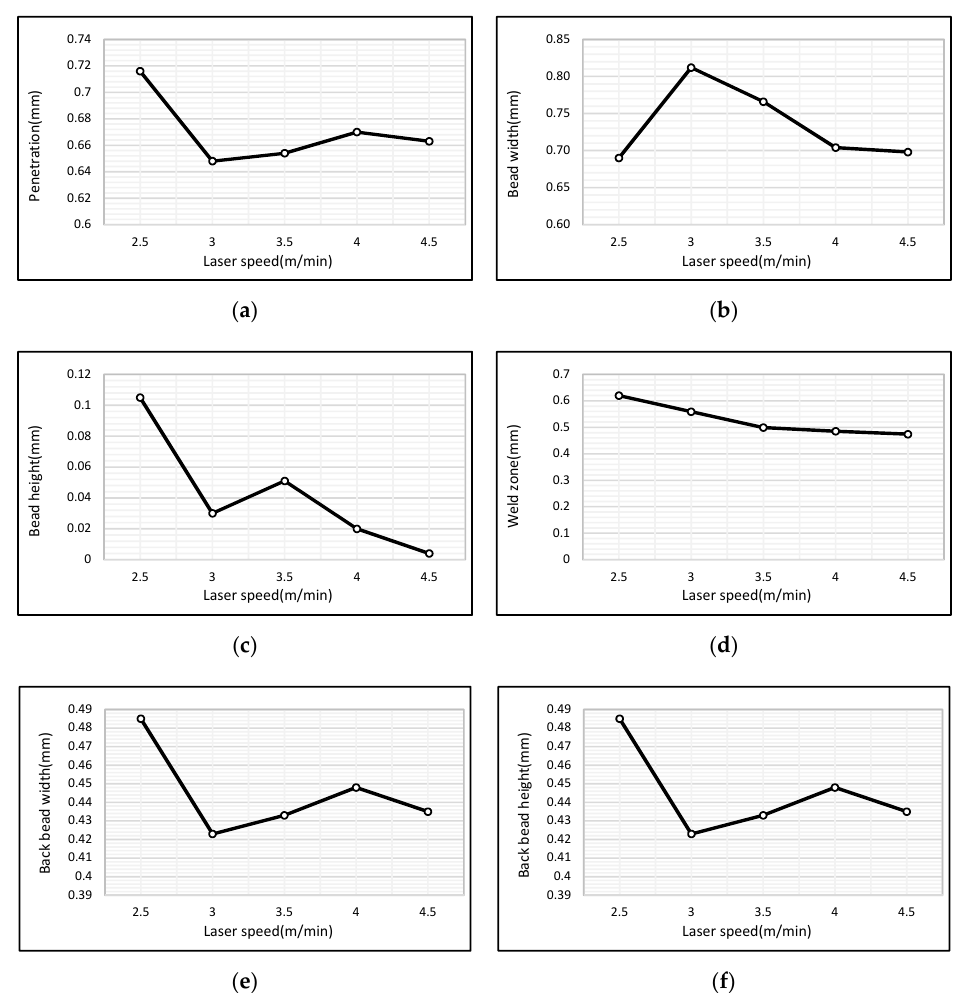
Figure 14. Changes in section observation measurement values.( a ) Penetration; ( b ) Bead width; ( c ) Bead height ( d ) Weld zone; ( e ) Back bead width; ( f ) Back bead height.